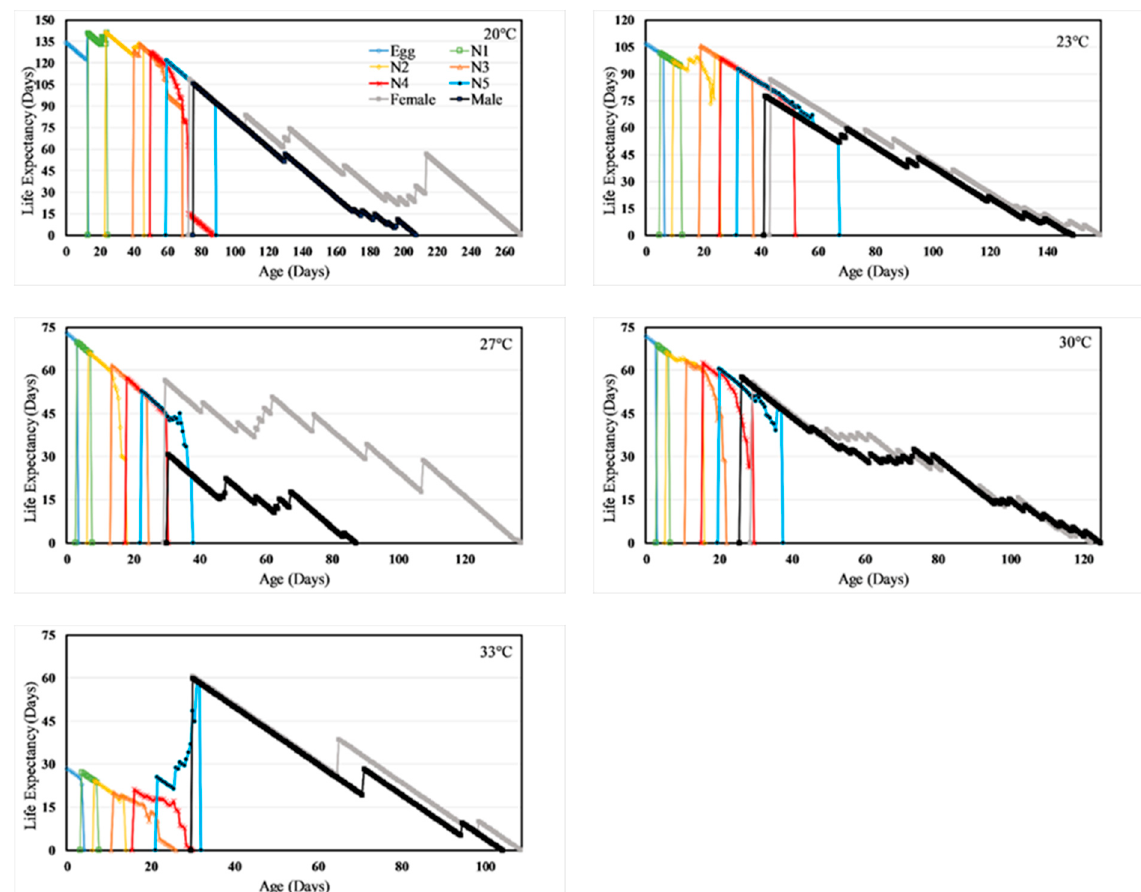
Figure 3. Temperature dependent age-stage-specific life expectancy ( e xj ) of H.